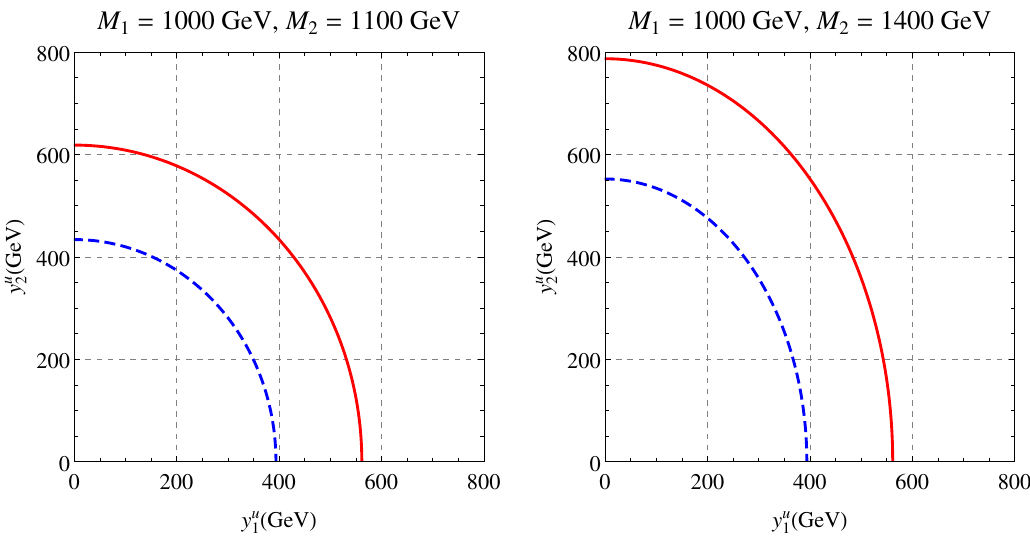
Figure 3 . First generation mixing bounds from Higgs couplings data, Blue dotted line is 68% CL and Red line corresponds to 95% CL. Values of the Yukawa couplings below the corresponding curve are